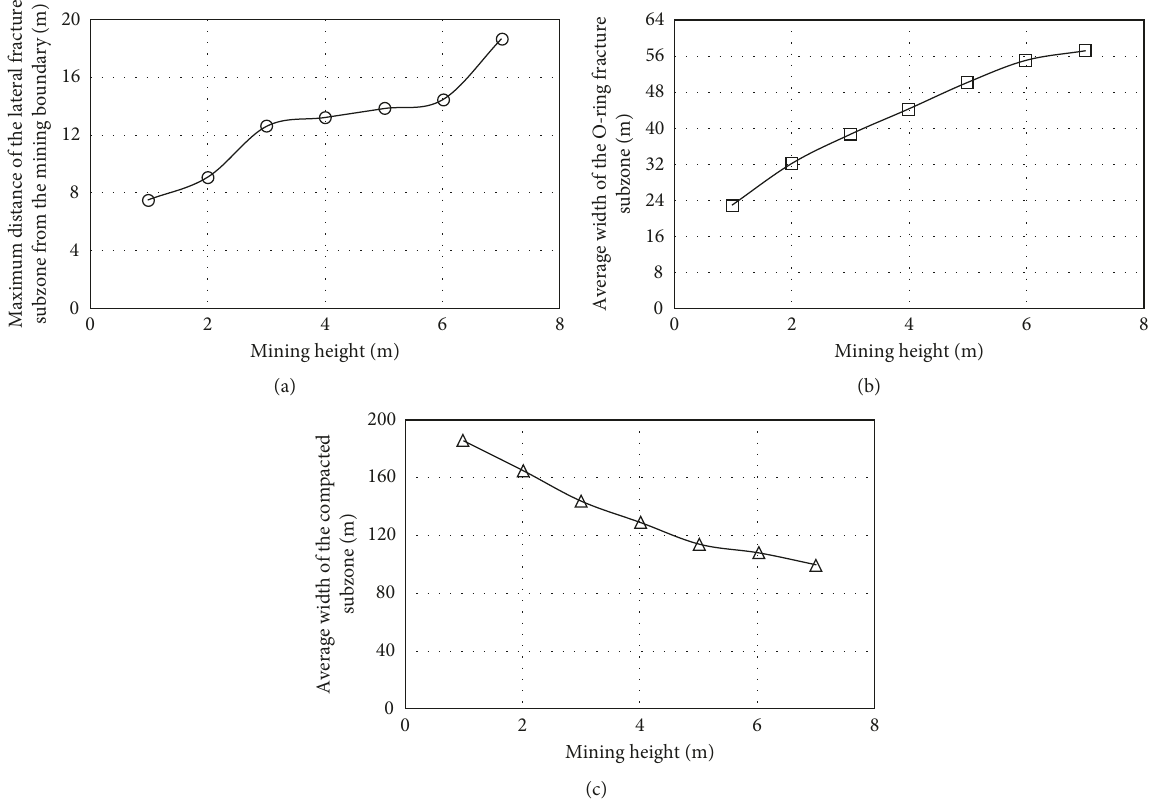
Figure 8: Laws of variation of the horizontal subzones of the GFFZ under different mining heights: (a) lateral fracture subzone; (b) O-ring fracture subzone; (c) compacted